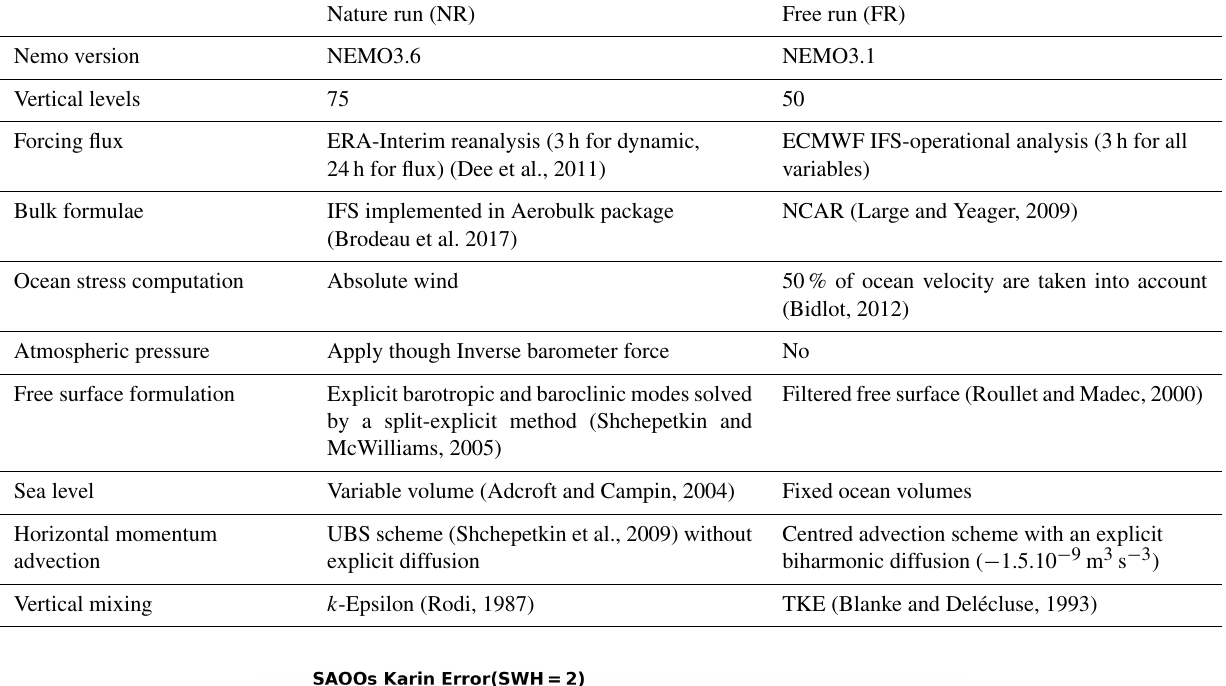
Table 1. Differences in model parameterization between the nature run (NR) and assimilated model (AR) (Benkiran et al., 2021).